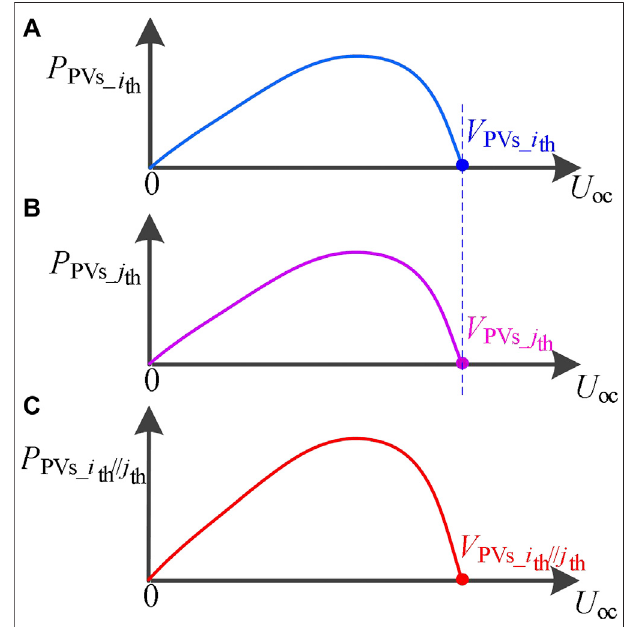
FIGURE 8 | PV power generation curves in the independent or parallel- connected types: (A) The power generation curve of the i th PV string; (B) The power generation curve of the j th PV string; (C) The power generation curve of i th and j th PV parallel